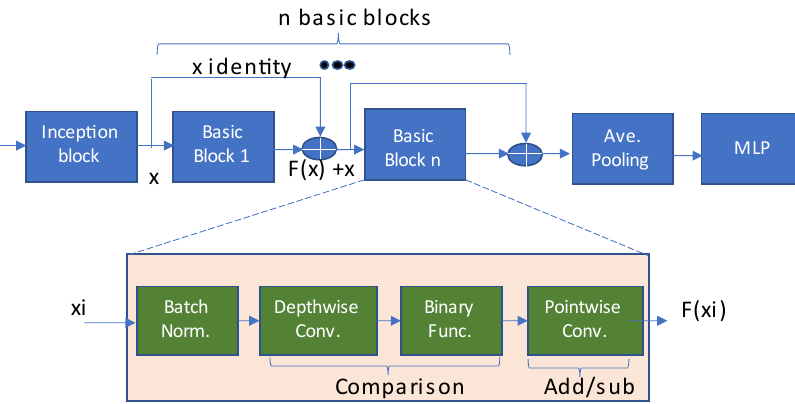
Figure 30. Block representation of comparator-based neural network [15]. The basic block comprises a set of operating functions as batch normalization, depth- wise and pointwise convolution. Figure 31 depicts the presented CMP-PIM architecture, and it comprises image and kernel banks, memory subarrays, and a digital processing unit. Before the mapping of kernels into memory subarrays, they are binarized by binary unit of DPU. The obtained results are further drawn to corresponding subarrays.